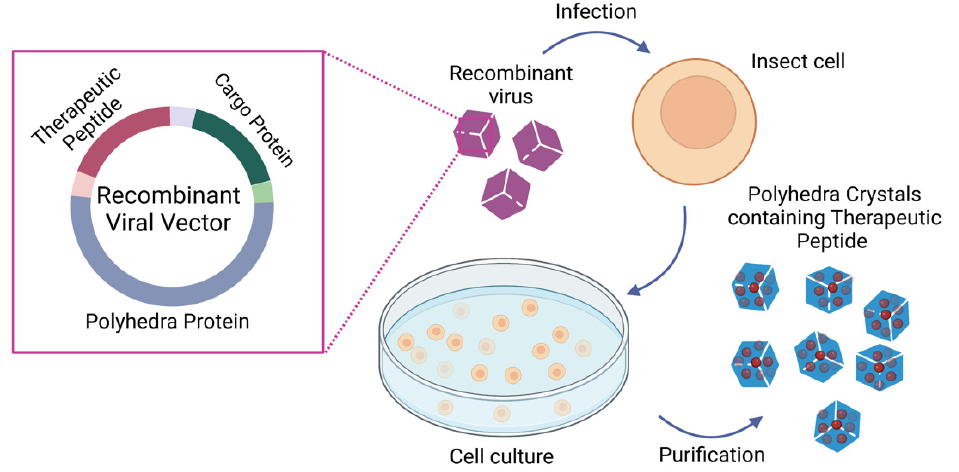
Figure 4. Polyhedrin delivery system (PODS) production: Schematic representation of the immobi- lization of therapeutic peptides into polyhedra crystals. Briefly, a recombinant viral vector carrying polyhedra protein, cargo protein, and the therapeutic peptide is used to transduce insect cells. The infected cells produce polyhedra crystals containing the therapeutic peptide, which are purified with differential centrifugation. The mechanical properties of polyhedra allow the purification of polyhedra crystals without compromising the therapeutic peptide functionality. This figure was created with BioRender.